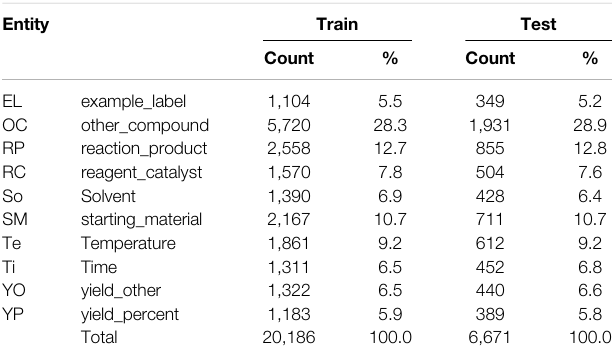
TABLE 1 | Entity distribution in the of fi cial training and test sets of ChEMU benchmark dataset.